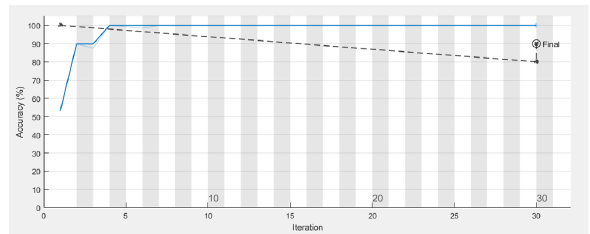
Figure 10. Accuracy rate of CNN during the training phase.